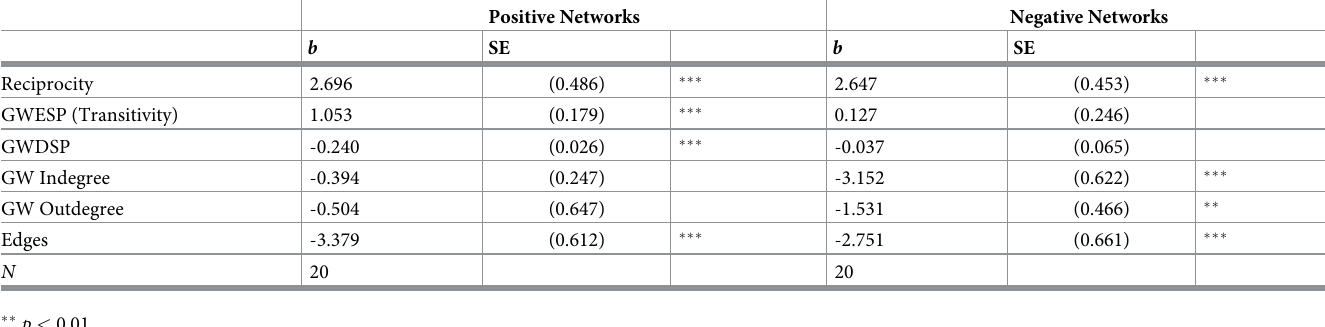
Table 1. Meta-analyses of ERGM coefficients by network